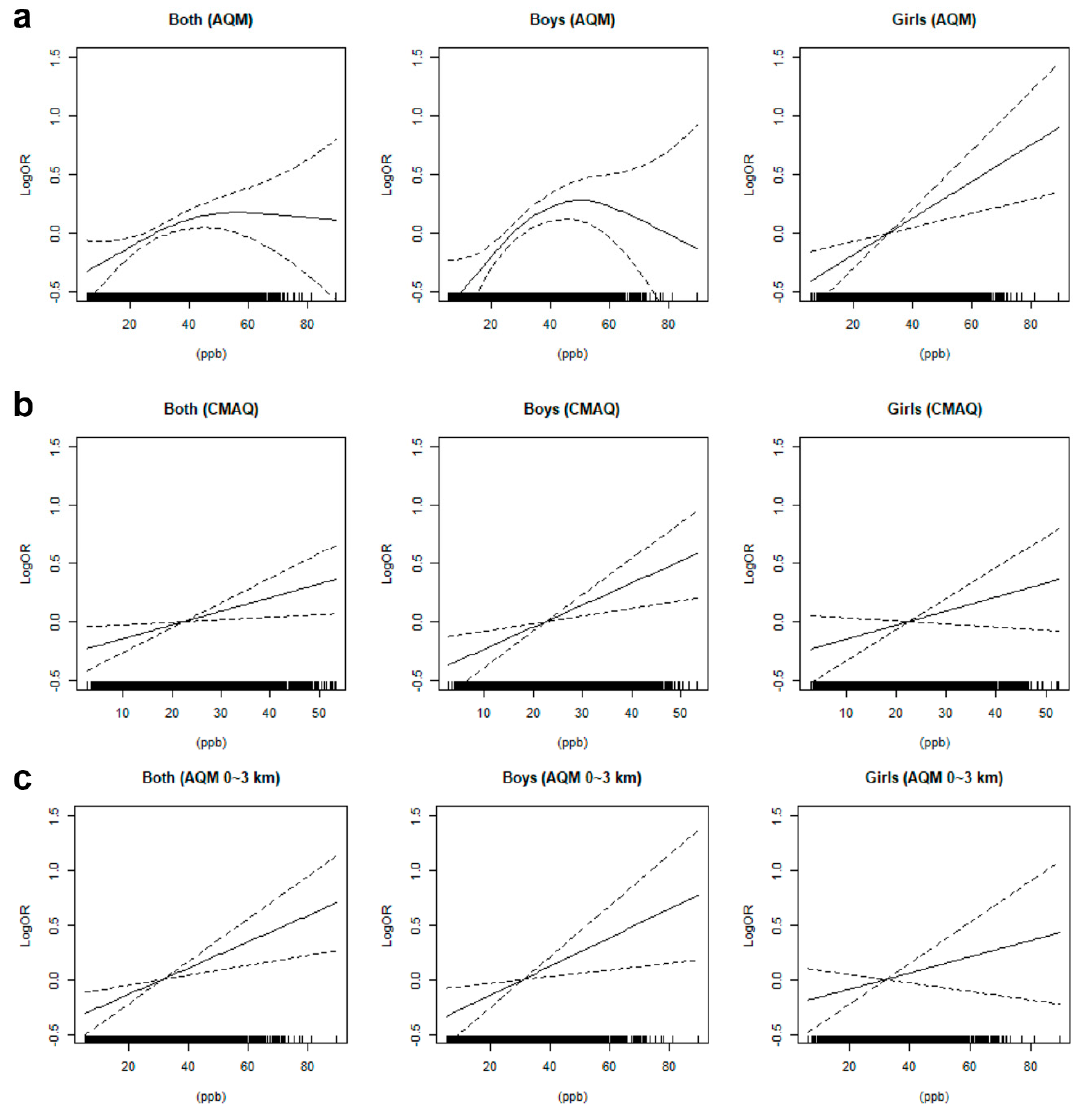
Figure 4. Associations between atopic dermatitis symptoms and the estimated exposure to NO 2 . Penalized regression curve (solid line) with a 95% confidence interval (two dashed lines) based on ( a ) AQM-NO 2 in all patients, ( b ) CMAQ-NO 2 in all patients, and ( c ) AQM-NO 2 from a subgroup residing within 3 km from AQM stations. Statistical analyses were performed after controlling for age, sex, SCORAD at enrollment, the presence of fever, use of topical corticosteroids, day of the week, and ambient temperature and humidity.